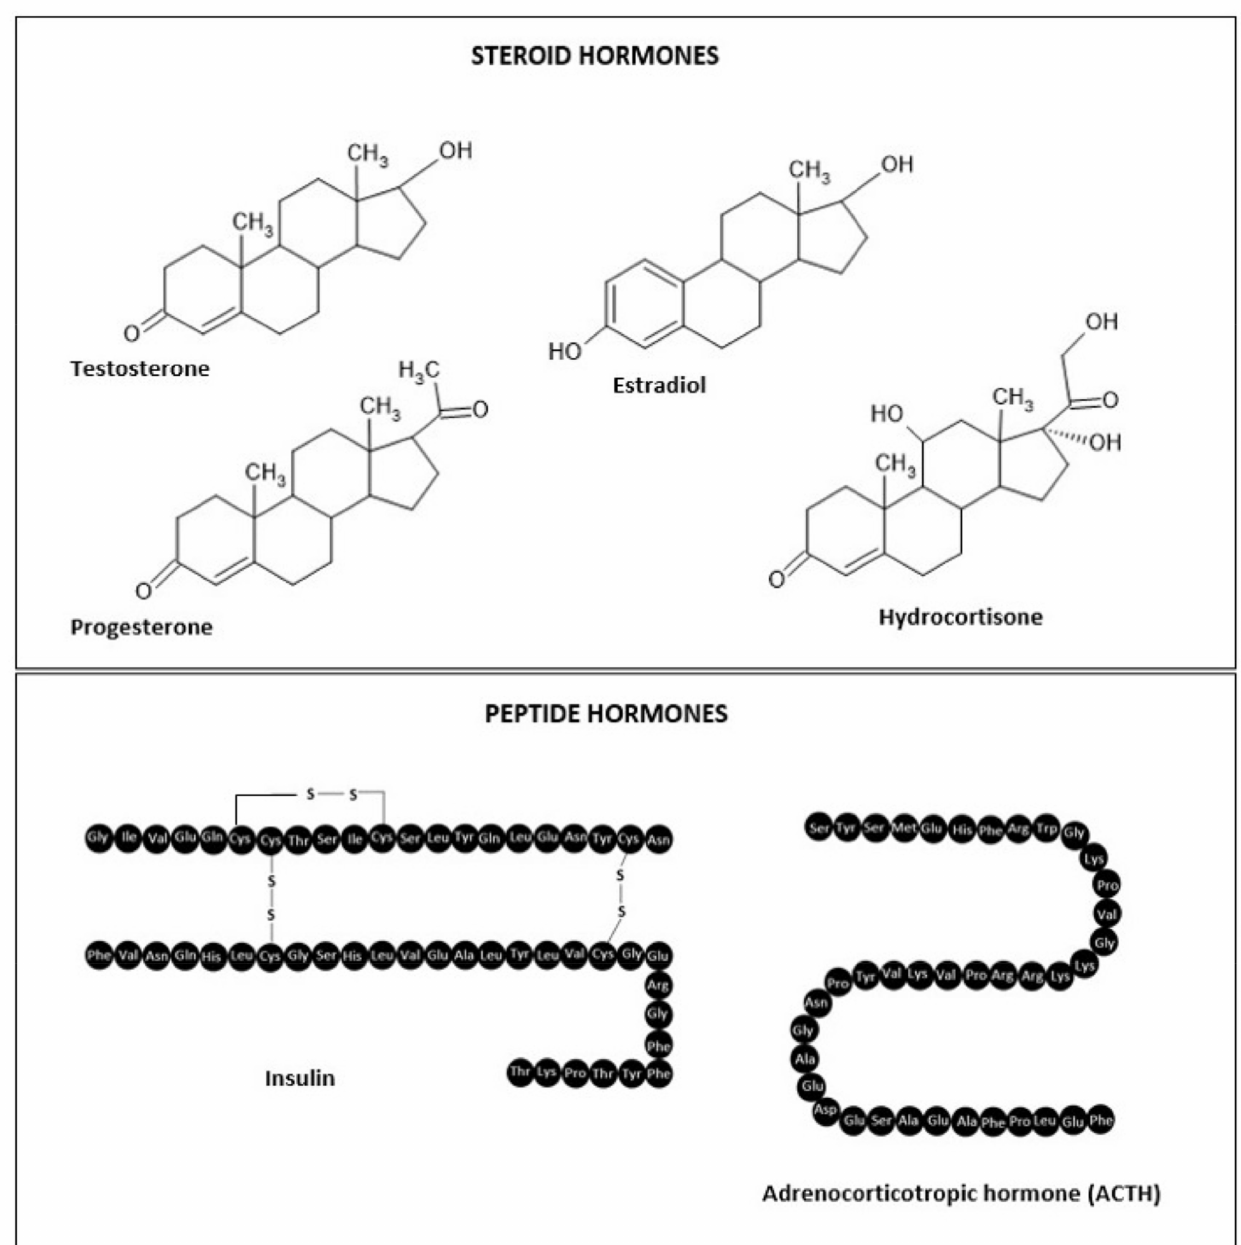
Figure 1. Chemical structures of hormones (created with ACD/ChemSketch software 2020.2.1, Advanced Chemistry Development, Inc., Toronto, ON,